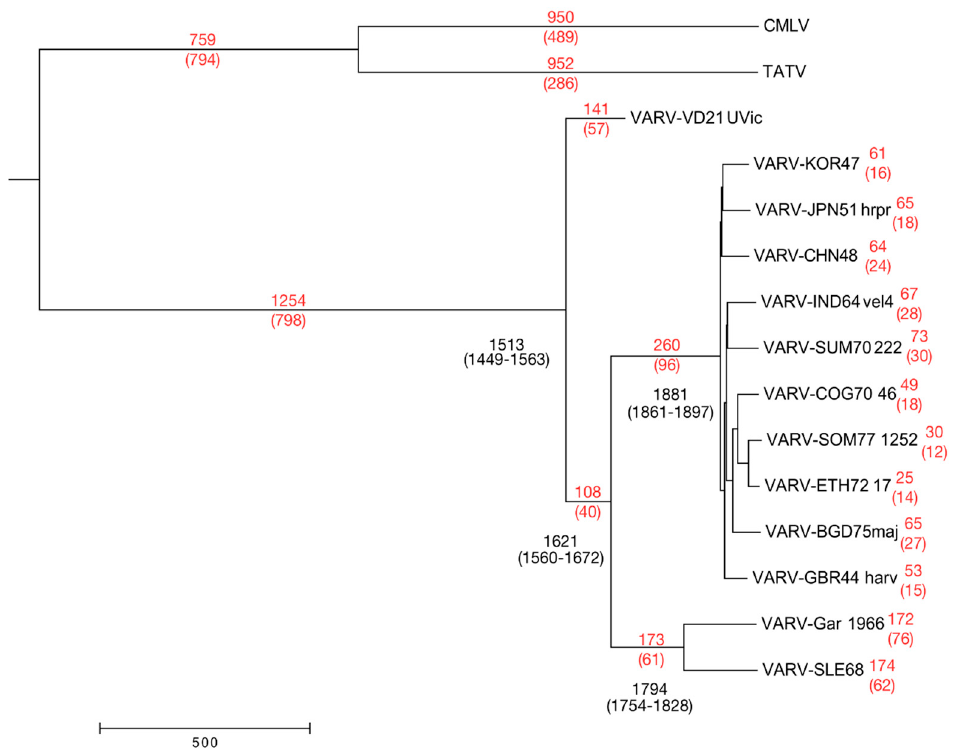
Figure 5. Maximum clade credibility tree depicting the evolutionary history of VARV, CMLV, and TATV species. The VARV, CMLV, and TATV genomes were aligned with MAFFT and cropped to the poxvirus core region between the orthologs of VACV-Cop-F4L and VACV-Cop-A24R, and any columns containing a gap were removed. The median estimated tMRCA for each strain is adjacent to major nodes of the tree, with the 95% higher posterior density (HPD) interval, the range covering 95% of all estimates, below. The time since the most recent divergence event as well as the number of unique SNPs (in brackets) is reported (red) for each branch. The scale bar is in years.